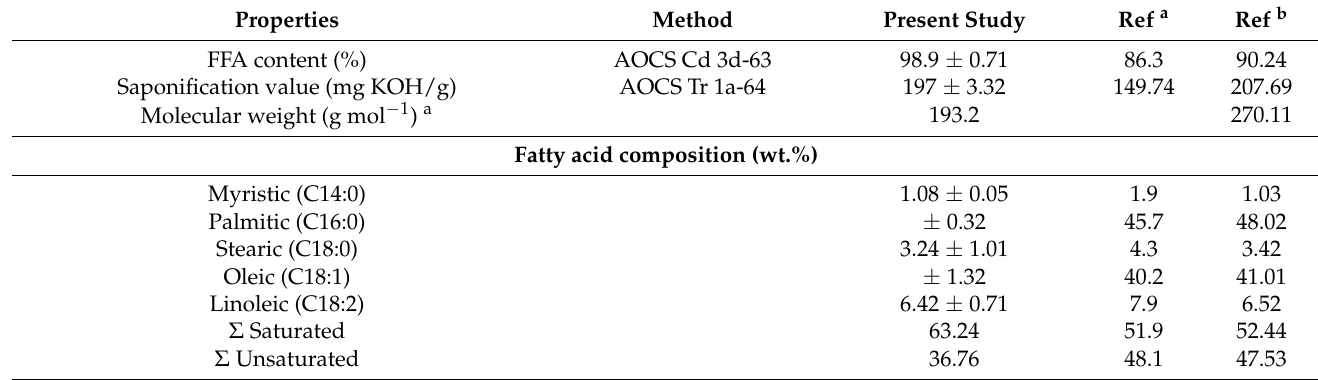
Table 3. Chemical properties and fatty acid composition of the